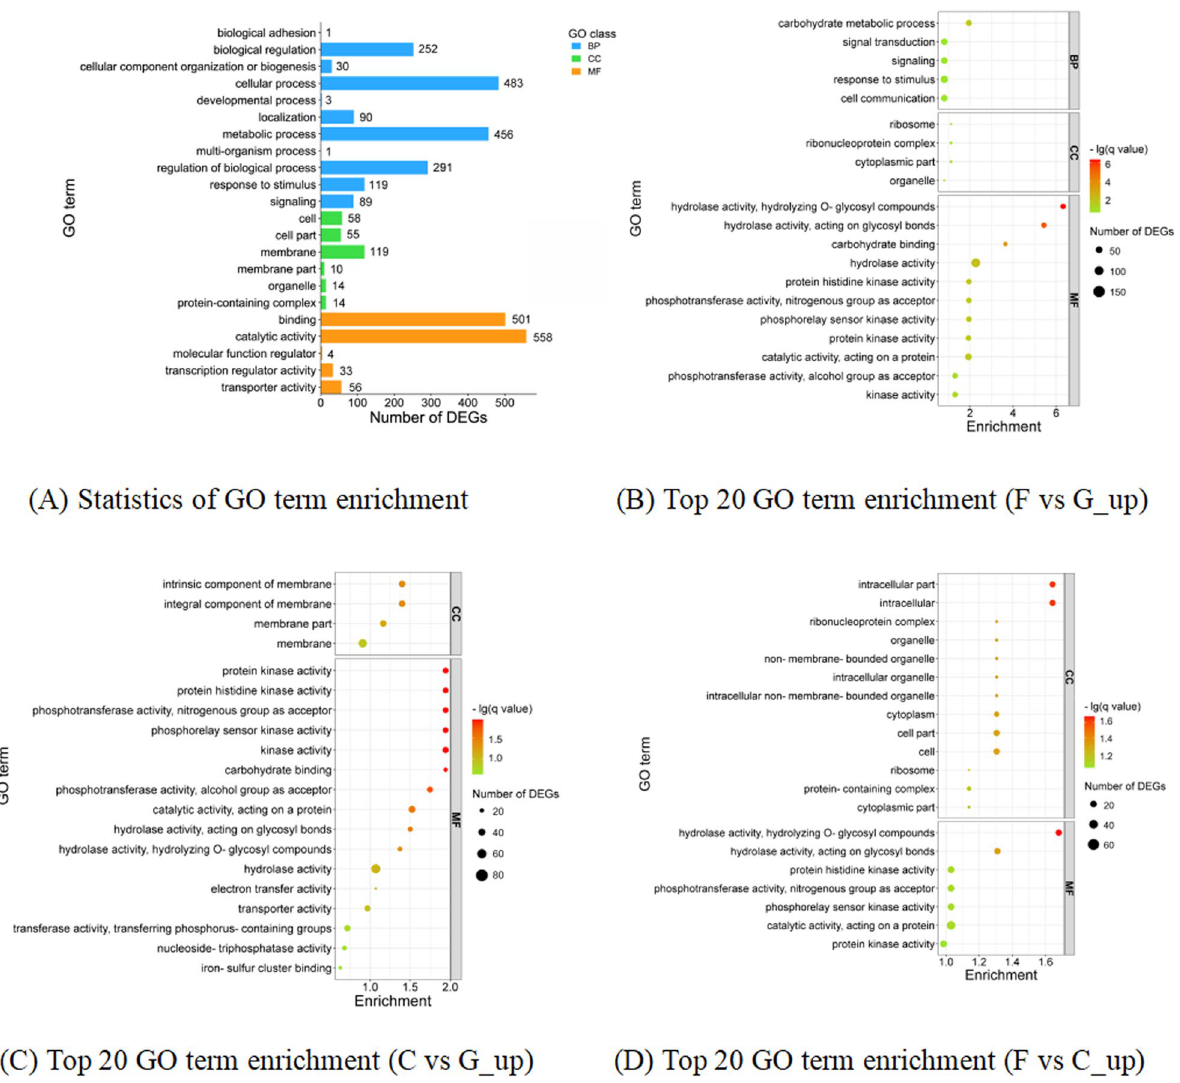
Fig. 2 GO enrichment results of DEGs. A : Annotation results of total DEGs. B : GO significant enrichment results of upregulated DEGs in F vs G combination. C : GO significant enrichment results of upregulated DEGs in C vs G combinations. D : GO significant enrichment results of upregulated DEGs in F vs C combination. BP biological process, CC cellular component, MF molecular